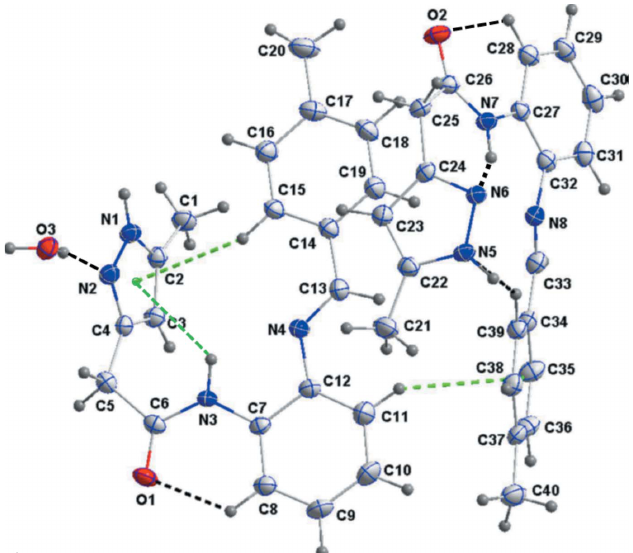
Figure 1 The asymmetric unit of the title compound, with the labelling scheme and 50% probability ellipsoids. The C—H (cid:2)(cid:2)(cid:2) O and C—H (cid:2)(cid:2)(cid:2) N hydrogen bonds are shown as black dashed lines and the C—H (cid:2)(cid:2)(cid:2) (cid:2) (ring) interactions by green dashed lines (see Table 1 for details).